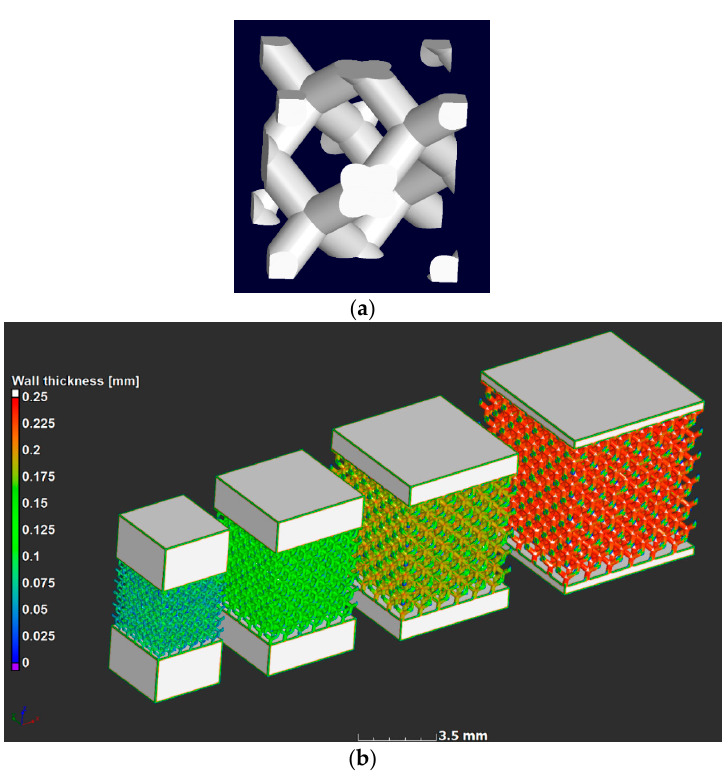
Figure 1. Design of microlattices showing ( a ) a single unit cell design of diamond type, and ( b ) the four full CAD lattice design used with unit cell sizes 0.6, 0.8, 1.0, and 1.2 mm, with strut thickness analysis.